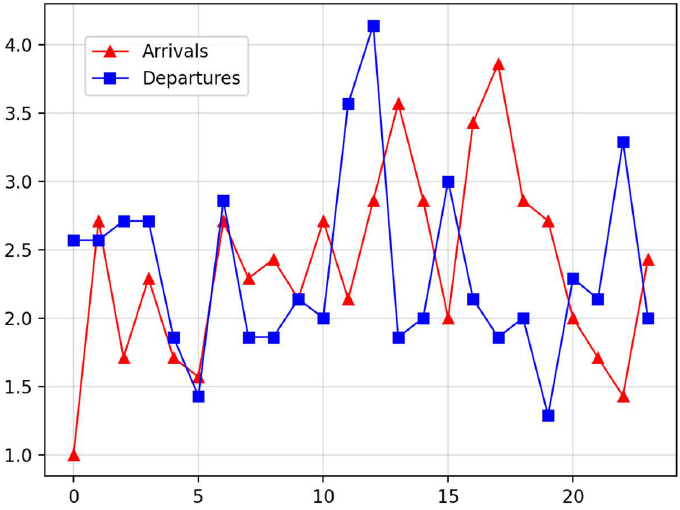
Figure 12. A line chart of the ship arrivals and departures at Chongqing Port for one day. Generally speaking, the arrival and departure of ships were roughly equal at the same time point; the highest was from 10:00 AM to 16:00 PM, and the lowest was from